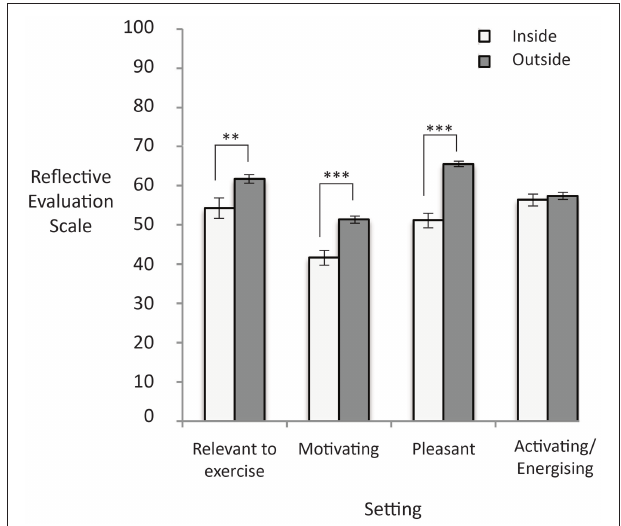
FIGURE 2 | Higher scores represent higher reflective evaluation ratings on the 0–100 response scale. Significant differences are noted with asterisks. Error bars reflect standard errors.